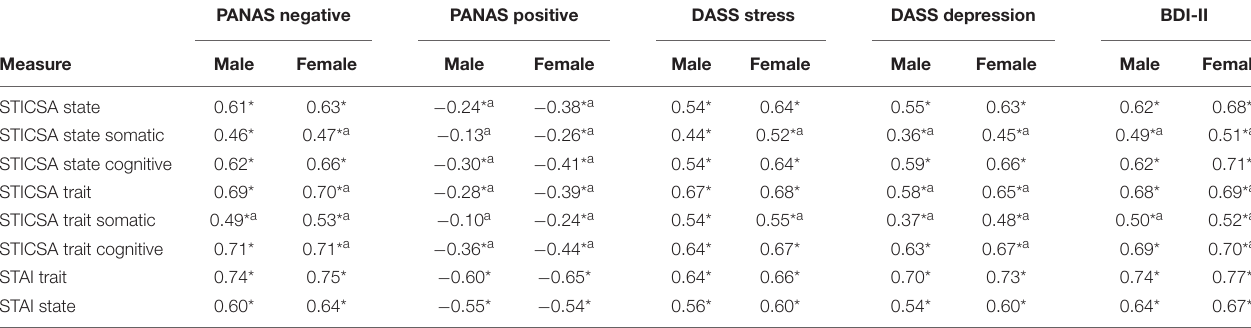
TABLE 6 | Pearson correlations investigating the divergent validity of the STICSA and STAI with measures of interest. PANAS negative PANAS